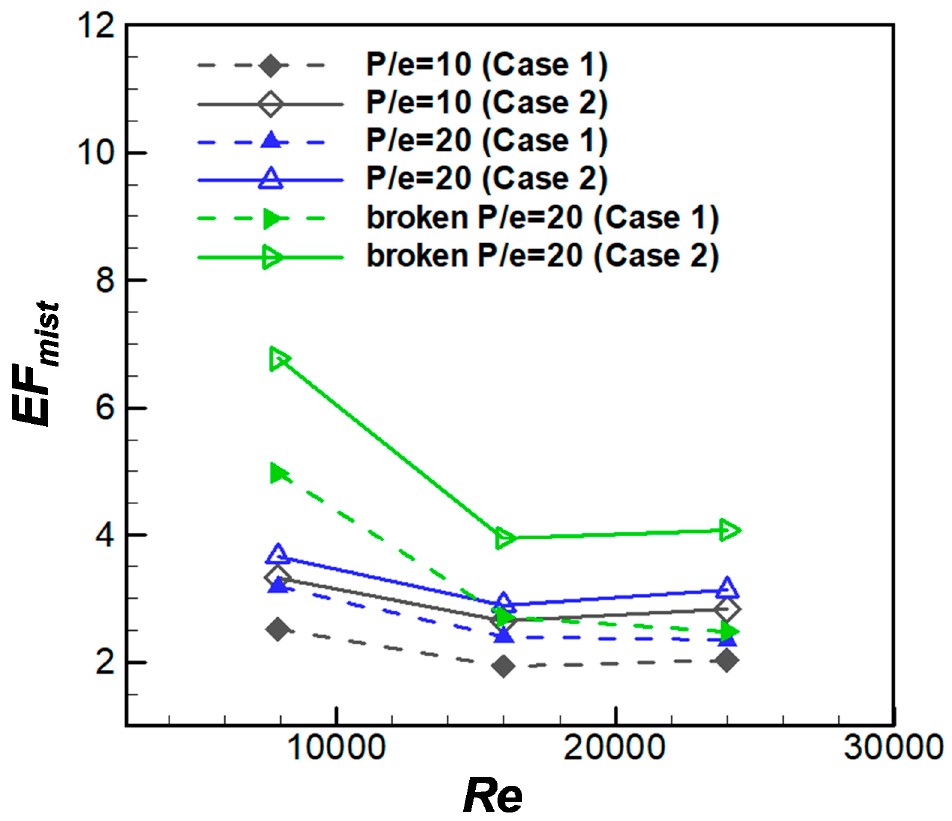
Figure 12. Heat transfer enhancement ratio.